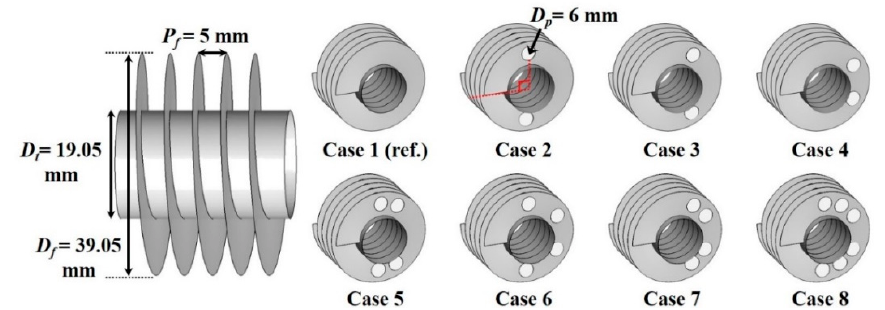
Figure 2. Fin configuration with different perforation locations. Case 1: Spiral fin (reference case). Location of perforation on fin from leading edge of tube: Case 2 at 90°, Case 3 at 120°, Case 4 at 150°, Case 5 at 90° and 120°, Case 6 at 90° and 150°, Case 7 at 120° and 150°, and Case 8 at 90°, 120°, and 150°.